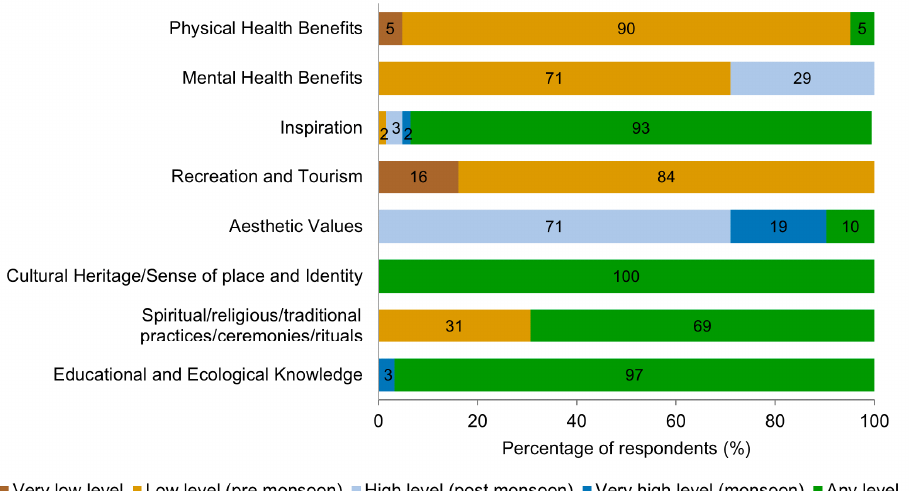
Figure 4. Water levels in the Beas River at which most CES are gained in both study sites.